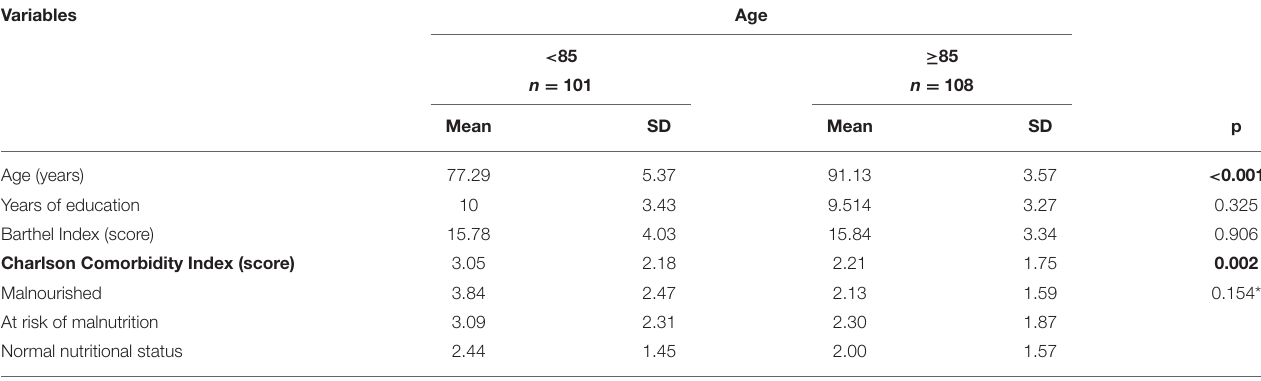
TABLE 2 | Distribution of participants’ characteristics by age groups. Variables